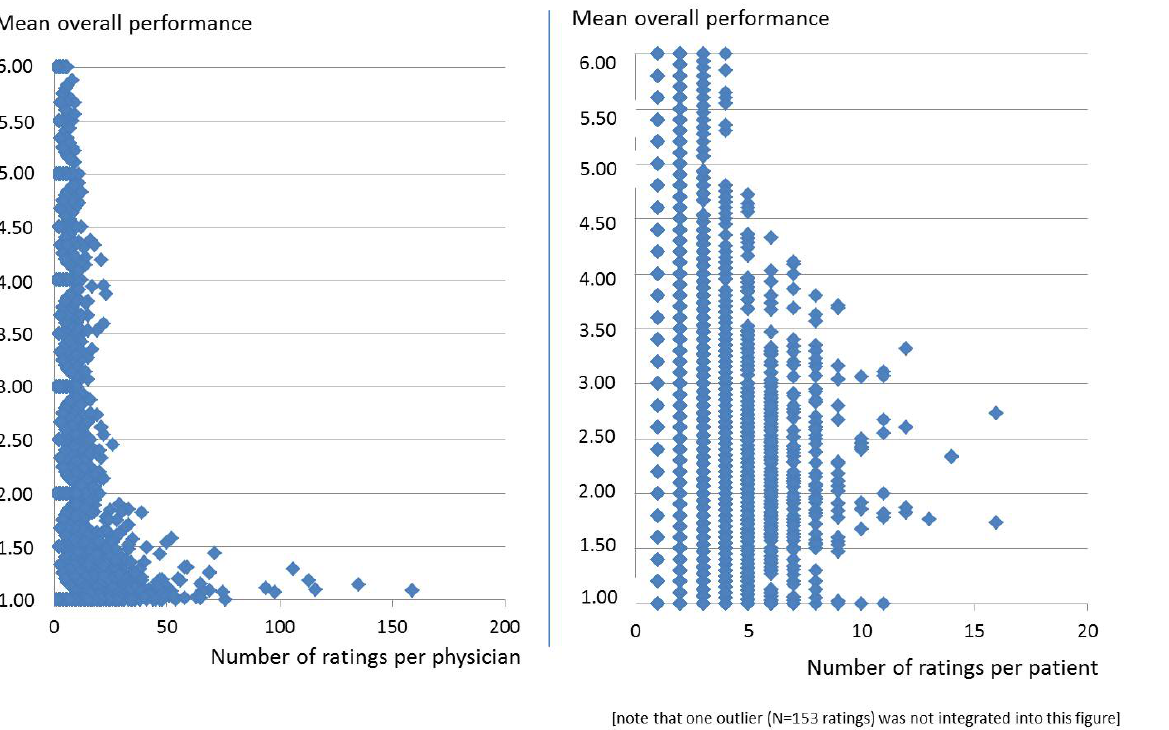
Figure 1. Scatterplot (bivariate); the number of ratings per physician (left)/patient (right) with the mean overall performance for a rated